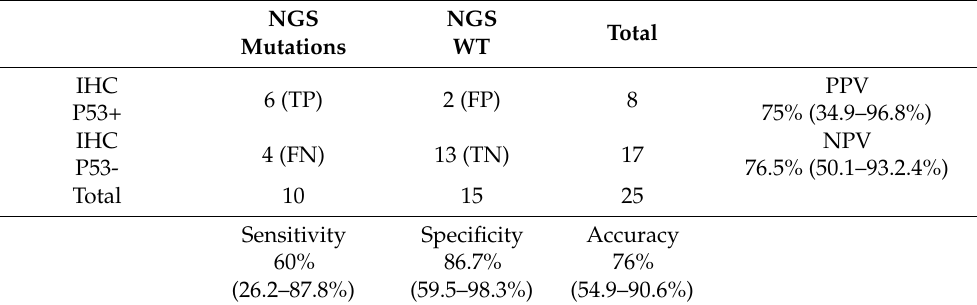
Table 3. Accuracy results and their 95% CI of TP53 genetic sequencing results versus p53 IHC staining results for >10% labelling